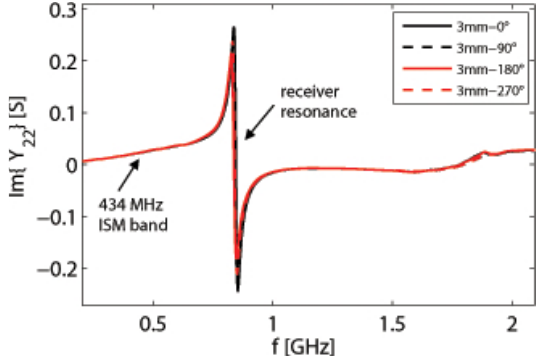
Figure 13. Measured angular of receiver susceptance Im( Y 22 ) in large frequency scale for a 3mm gap.